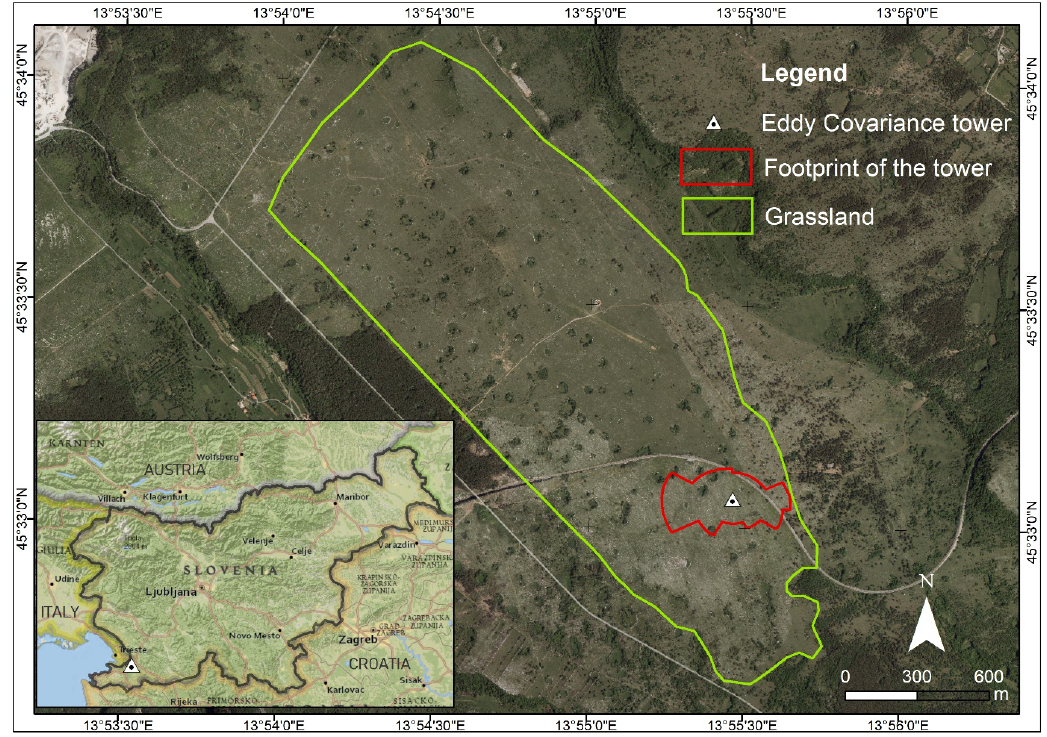
Figure 1. Study area, a karst grassland.